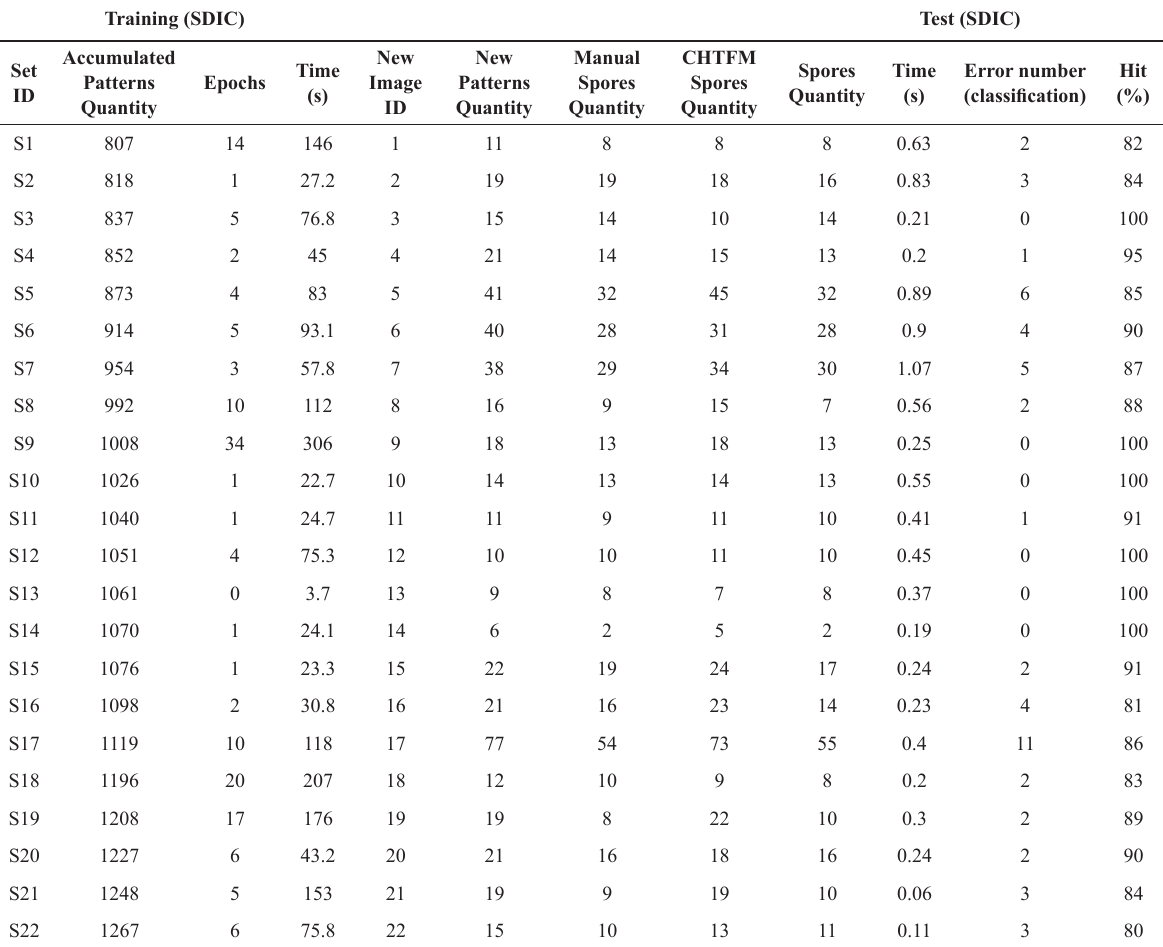
Training sets and results of the Test sets for SDIC